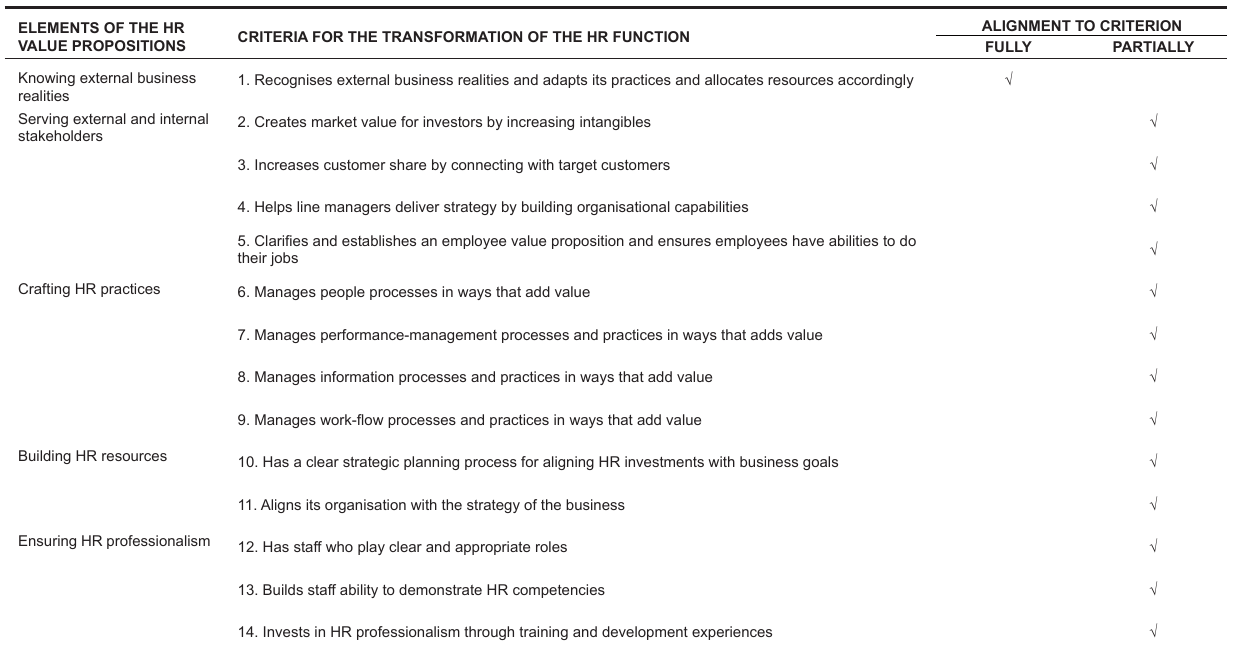
TABLE 7 Summary of research findings pertaining to meeting the 14